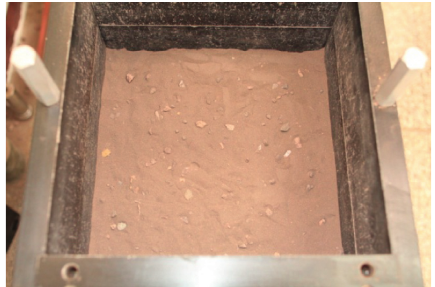
Figure 7: Photograph of rock-soil mixture G1.